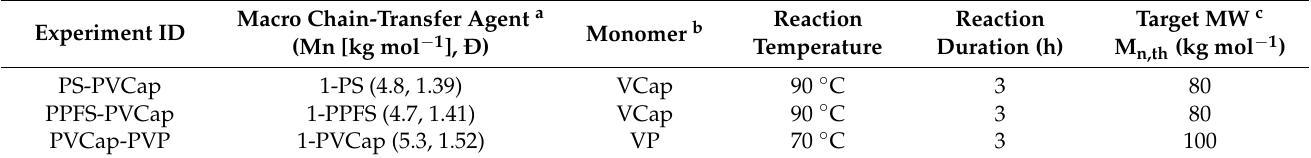
a Indicates the macro chain-transfer agent used in the chain extension reaction. Mn and Ð (values in parenthesis) represent the number average molecular weight and the dispersity of the synthesized macro chain-transfer agent used to chain extend. These were calculated using gel permeation chromatography. b The monomer used for chain extension. c Expected molecular weight (MW) if 100% monomer conversion is